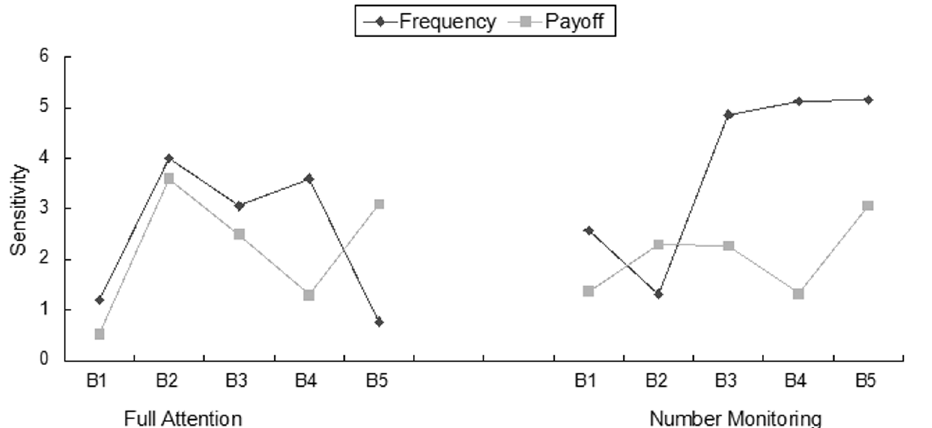
Figure 3. Group performance across blocks.